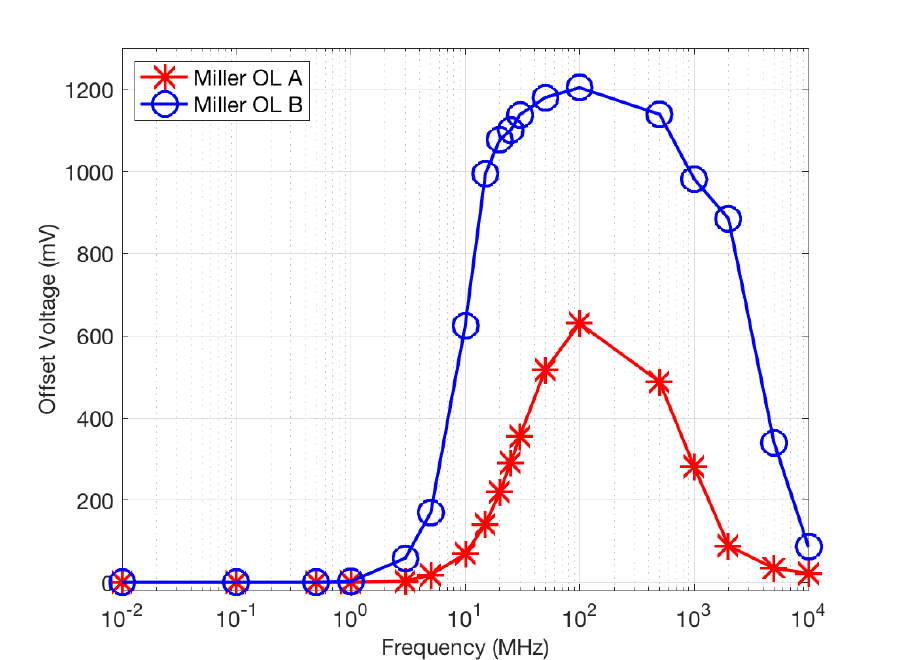
Figure 17. EMI induced offset in the Miller amplifier, open loop configuration.